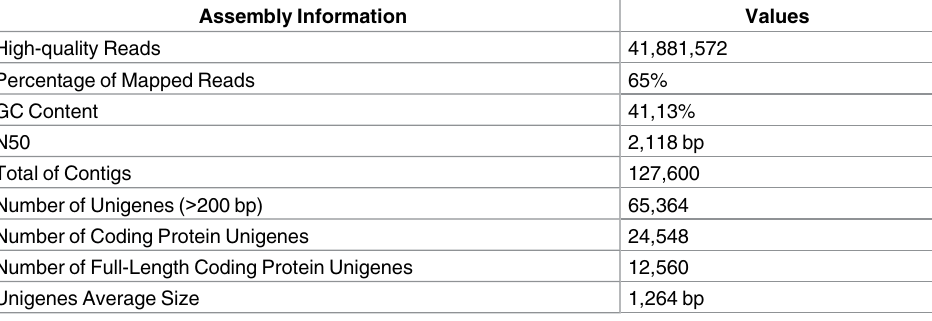
Table 1. Summary of C . arabica de novo transcriptome